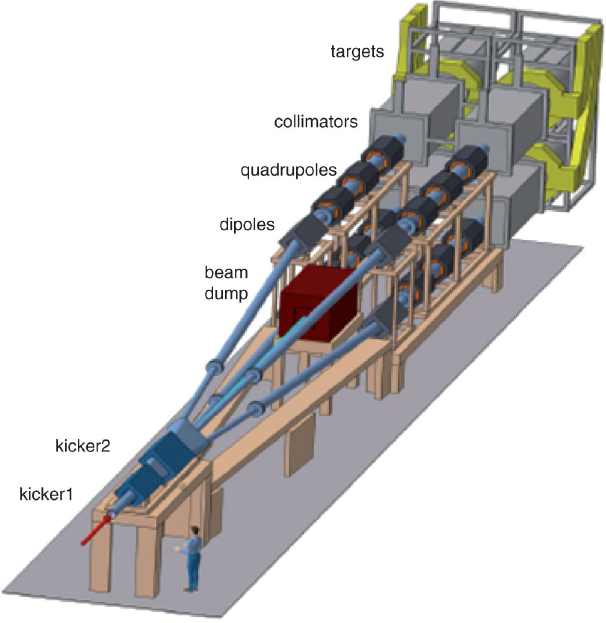
FIG. 2. The Super Beam beam transport and distribution system.